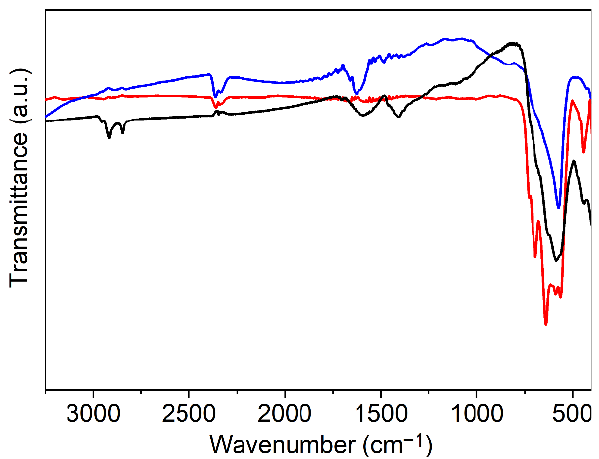
Figure A7. FTIR spectra with entire wavenumber range of iron oxide NPs (black) compared to spectra of neat magnetite (blue) and maghemite (red) powders. An expansion of spectra to wavenumber region of interest (900 to 400 cm −1 ) is shown in Figure 3.